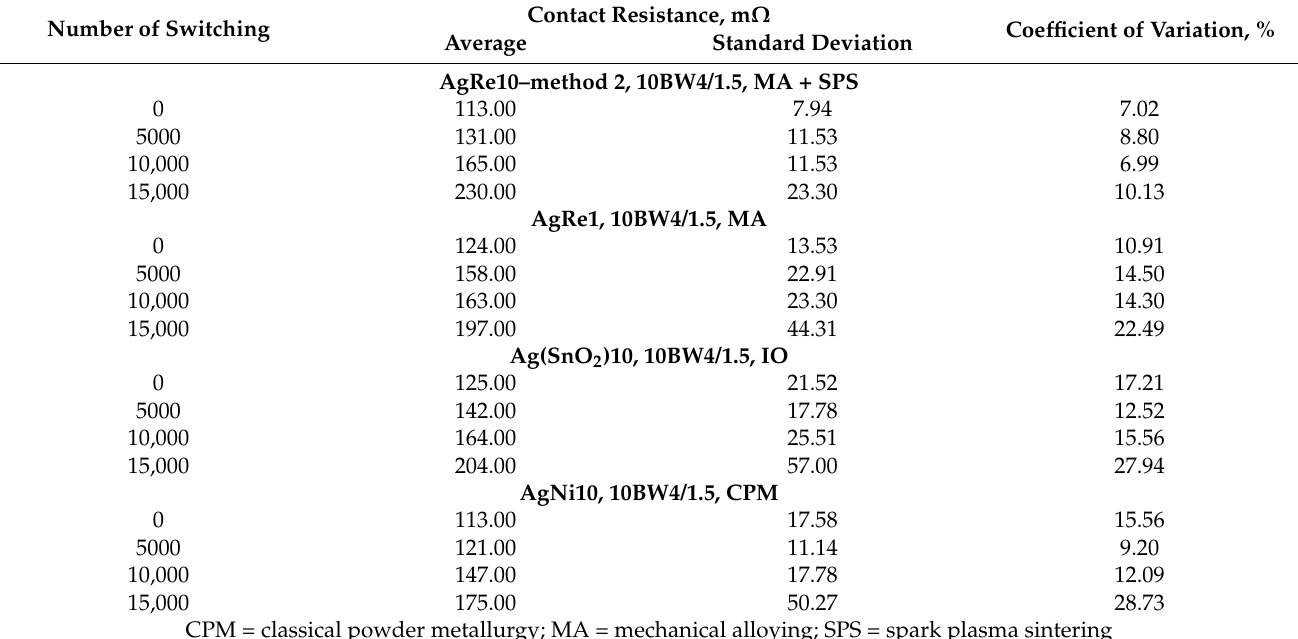
Table 6. Average and standard deviation and coefficient of variation of contact resistance, AC, 60